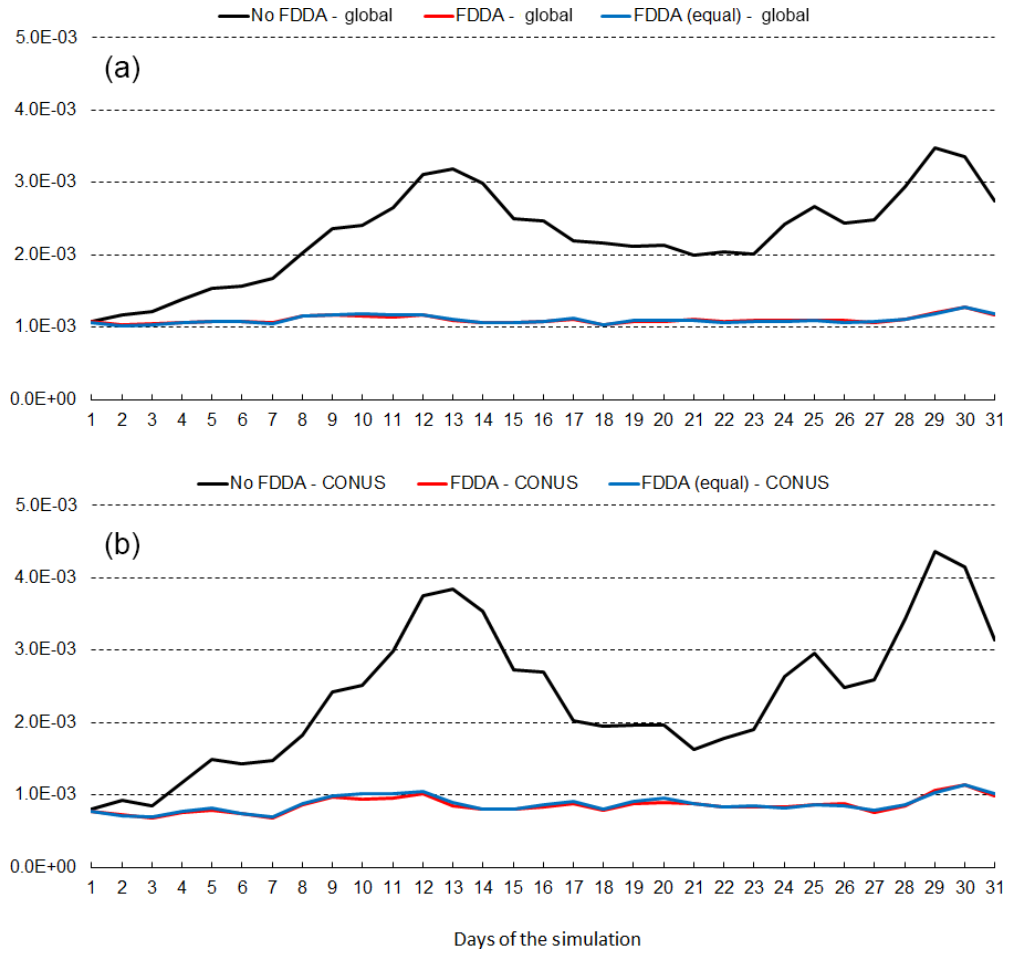
Figure 14. January 2013 time series plots of 2m water vapor mixing ratio ( q v ) RMSE for MPAS-A without FDDA (black line), MPAS-A with FDDA applied using weaker q v nudging (red line), and MPAS-A with FDDA applied at equal strength for all variables (blue line). Panel (a) shows results for the entire global domain, while (b) shows results for the CONUS